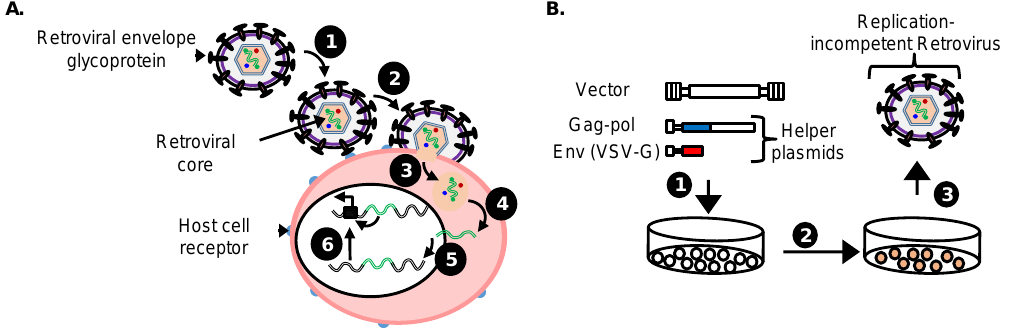
Figure 2. ( A ) Unique retroviral “single hit” during transduction of target cancer cells by replication- incompetent retroviral vector in an insertional mutagenesis screen. Replication-incompetent retroviral vector with a suitable envelope glycoprotein such as VSV-G (1) attach to the target cell receptors causing fusion between the membranes resulting in (2) cell entry of virion core into the cytoplasm where it (3) uncoats and the viral RNA is (4) reverse transcribed into double stranded preintegration DNA and transported into the nucleus where it (5) stably integrates into the chromosome and causes (6) insertional mutagenesis via known mechanisms such as enhancer-activation of a nearby promoter of a proto-oncogene; ( B ) Production of replication-incompetent retroviral vectors. (1) Human embryonic kidney 293 (HEK 293) cells are transiently transfected with vector plasmid and helper plasmids; (2) Vector virions are produced for 72 h; (3) Vector virions are harvested, filtered and concentrated 100-fold by ultracentrifugation for 18 h.